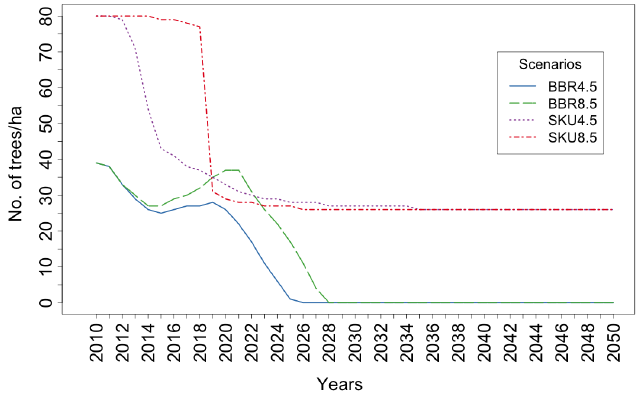
Figure 7. Number of adult trees in one hectare (sum of all species).